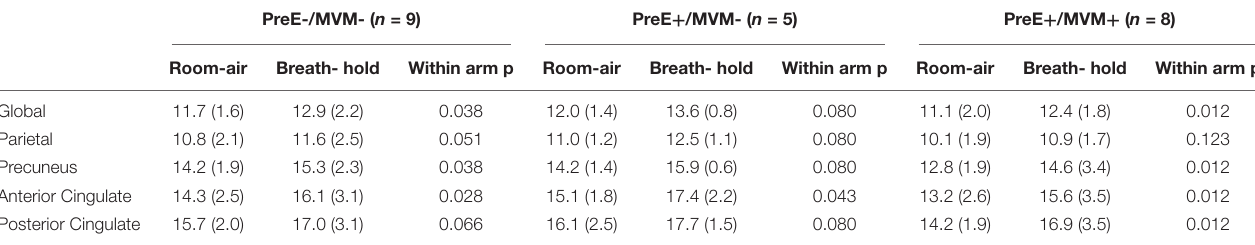
TABLE 2 | Cerebral blood flow during room-air breathing and breath-hold stratified by preeclampsia and maternal vascular malperfusion status. PreE-/MVM- ( n = 9) PreE + /MVM- ( n = 5) PreE + /MVM + ( n = 8) Room-air Breath- hold Within arm p Room-air Breath- hold Within arm p Room-air Breath- hold Within arm p